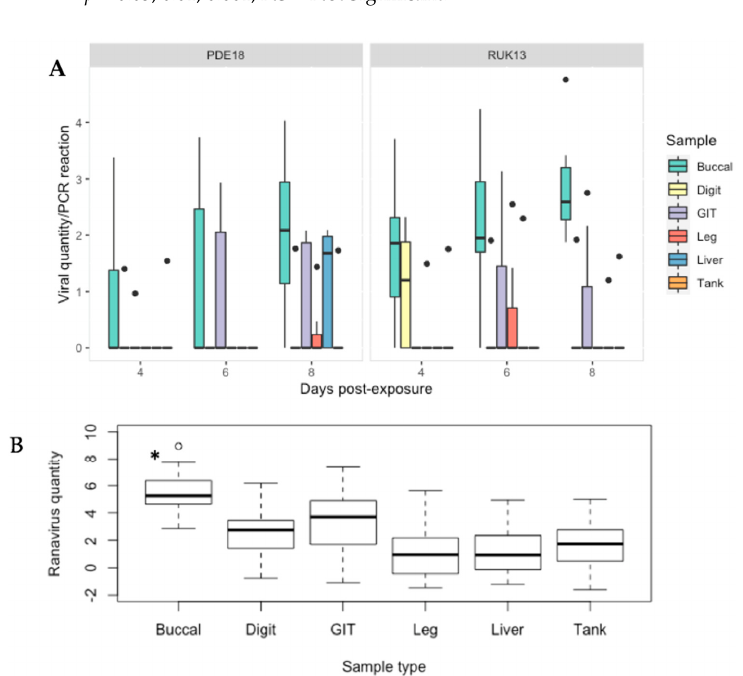
Figure 8. ( A ) Viral quantity per PCR reaction for buccal, digit and tank swabs, GIT, leg and liver tissue obtained from B. bufo from both virus treatment groups at 4, 6 and 8 days-post exposure. ( B ) Predicted probabilities of ranavirus quantities per 2 µ L PCR reaction generated from the zero inflated gaussian mixed model for sample type as a single factor. Black dots indicate outliers. * p < Table 4. Sample types ranked by detection rate (%) with significant differences of pairwise compar- isons between sample types illustrated overall and by virus type.